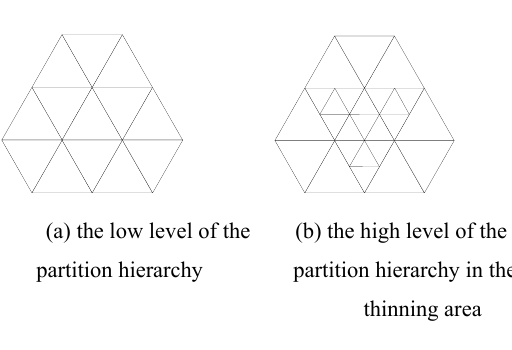
Figure 3 the thinning area in the QTM Alone with the continuous movement of the viewpoint, the thinning area will be changing, the triangle grids in the thinning area will be changing as well. Whenever the viewpoint is changing, he relationship between the blocks and the viewpoint needed to judge, then the triangle grids in the thinning area will be also